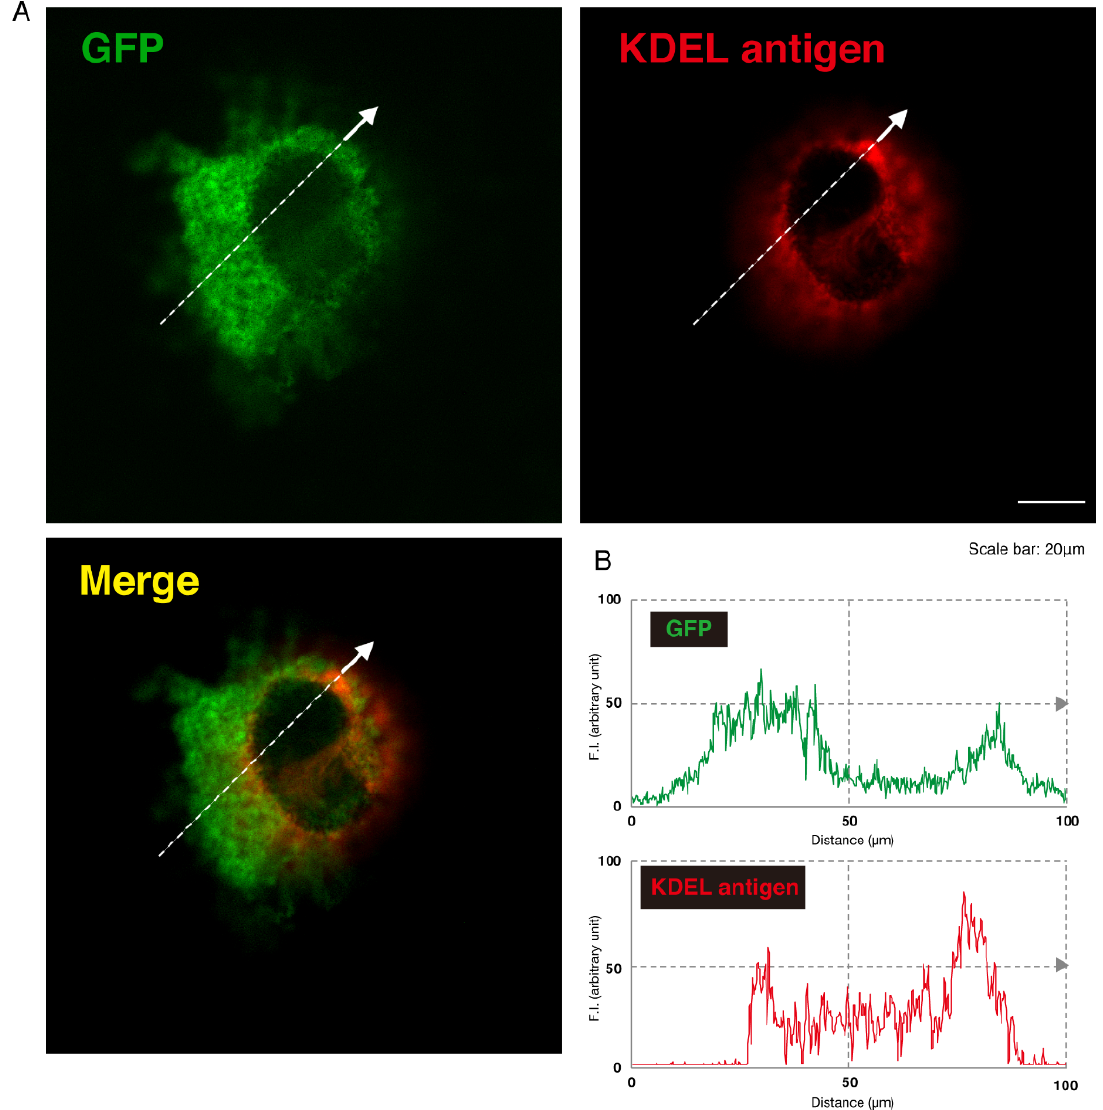
Figure 3. The Q39X mutant proteins are not present in the ER. ( A ) N1E-115 cells were transfected with the plasmid encoding the Q39X mutant construct of GFP-tagged AIMP1 (green). Transfected cells were stained with an antibody against the ER marker KDEL antigen (red). A merged image with a dotted arrow is also shown in the bottom panel. The scale bar indicates 20 µ m. ( B ) Fluorescence intensities (F.I., arbitrary unit) of green and red colors are shown along dotted arrows in A.